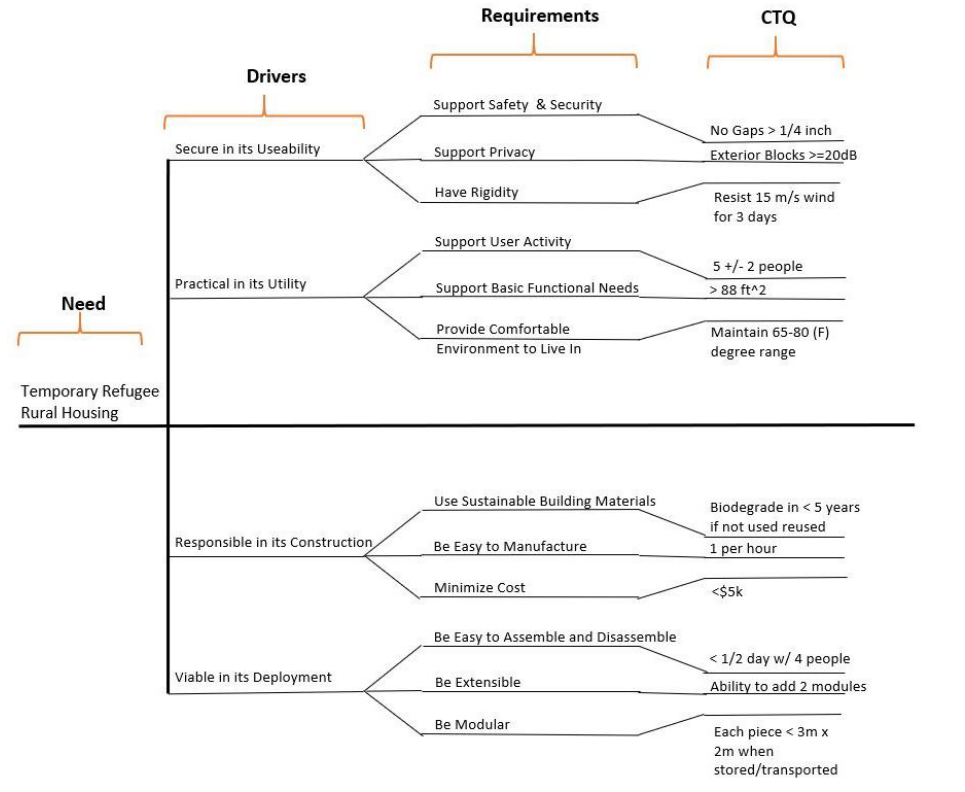
Figure 17. CTQ Diagram based on clustering of Customer Features (i.e., Requirements/Needs).